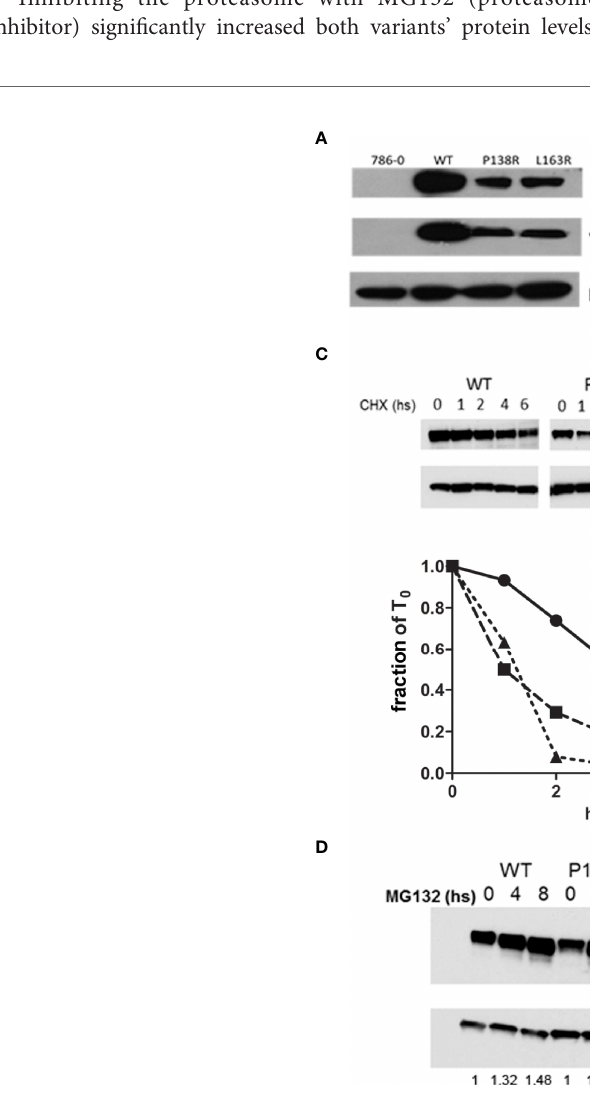
FIGURE 1 | Reduction in protein levels and half-life for P138R and L163R pVHL variants. (A) Representative Western blot showing the levels of GFP and VHL protein obtained in each cell line and b -actin as loading control. (B) Expression of VHL measured by qrPCR and graphed as fold change for P138R and L163R pVHL variants compared to pVHL WT. *p < 0.0001, **p = 0.0424, one-way ANOVA and Tukey ’ s posttest. (C) Proteins levels obtained by Western blot after treatment with 50 µg/ml cycloheximide to inhibit protein translation. Quanti fi cation was done in order to plot the proportion of protein levels on the different time points evaluated. The dotted line indicates the 50%. (D) Inhibition of proteasome by 5 µg/ml MG 132 for cell lines expressing WT, and P138R and L163R pVHL variants. Results are shown by a representative Western blot for VHL and b -actin. Relative quanti fi cation of the bands is shown under each